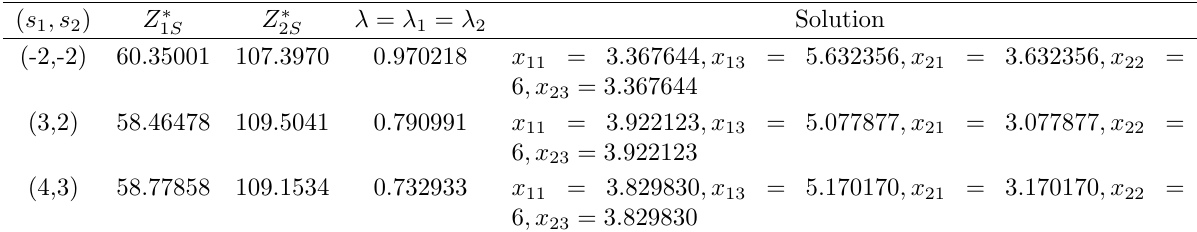
Table 3. Solution table for ( s 1 , s 2 ) in the exponential membership function for OV Model-6